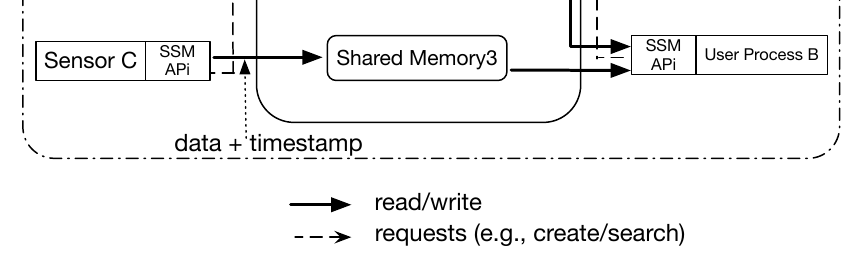
Figure 3. The usage of SSM. Table 1. Summary of